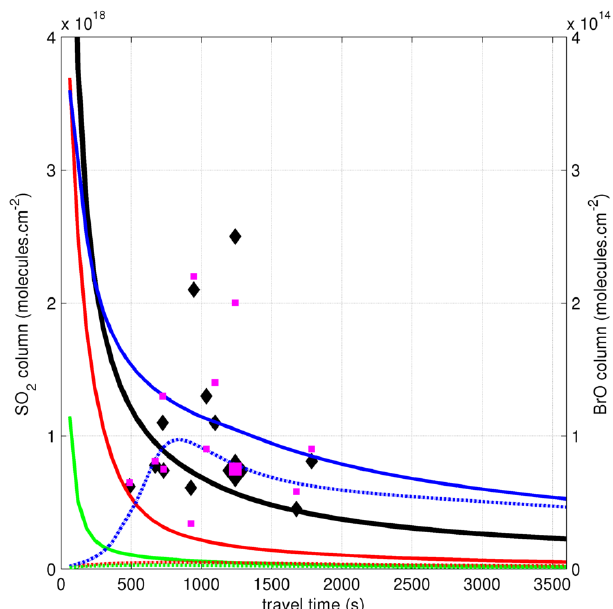
Figure 10. Evolution of vertical column SO 2 and BrO for the six model scenarios discussed in the text (“low Br / S” initialisation). SO 2 is plotted against the left axis scale in black (variation between the scenarios is minimal). The BrO columns are plotted against the right axis scale using the same colour code as in Fig. 7. The black diamonds represent the spectroscopic measurements of SO 2 , the magenta squares represent the spectroscopic measurements of BrO. The larger markers represent the 2012-07-27 measurement contem- poraneous with near-crater measurements of both O 3 and SO 2 .